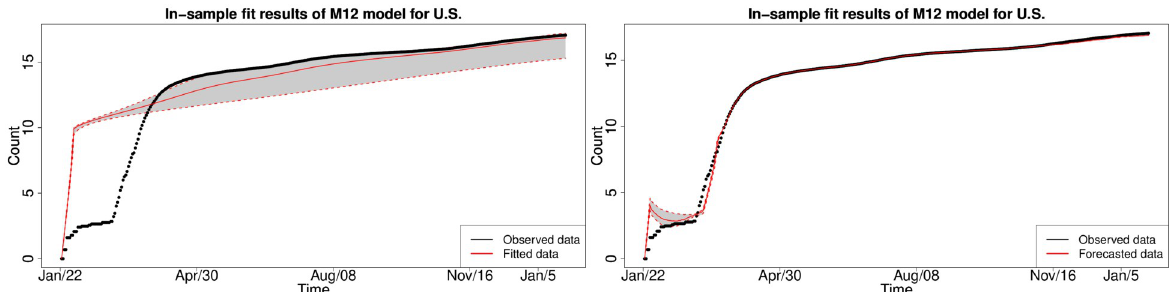
Fig 13. In-sample fit results for the US for the period January 2020—January 2021. In-sample fitted plot (y-axis in log scale) for the US by Model 12 single splice (left) and Model 12 2-splice (right) (January 2020—January 2021).